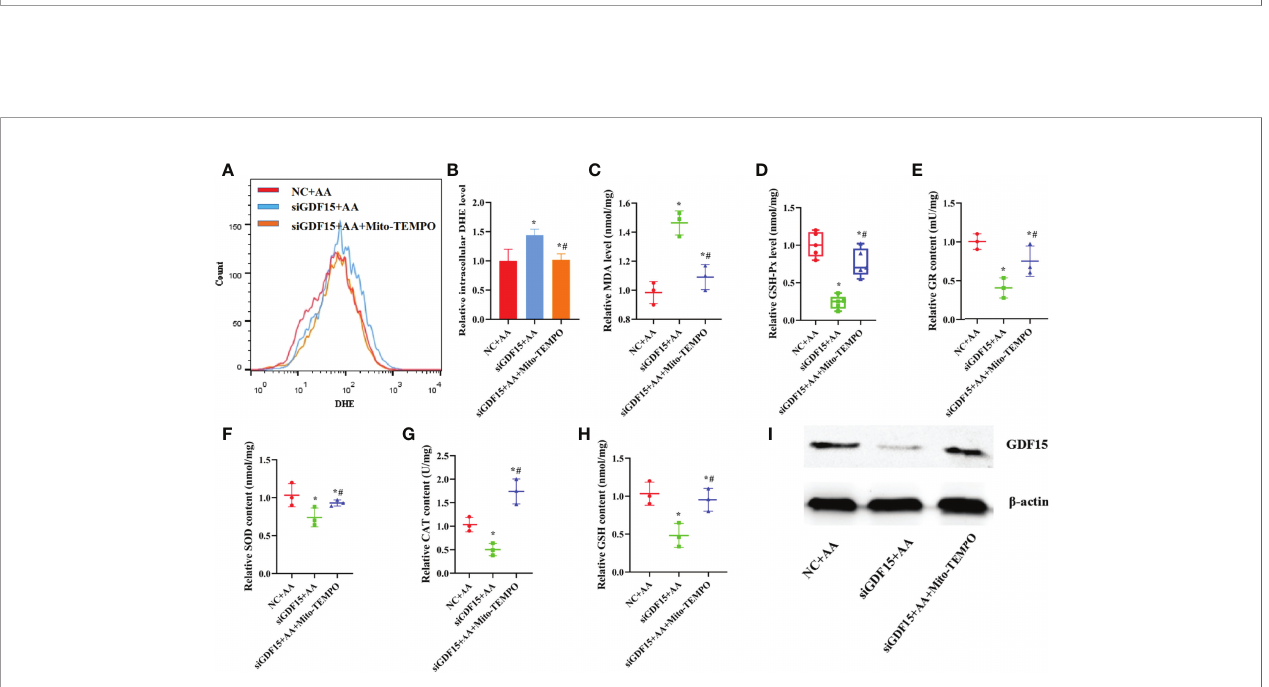
FIGURE 6 | Silencing of GDF15 caused damage to antioxidant capability of KGN cells (A, B) silencing of GDF15 signi fi cantly promoted the levels of O 2- levels in KGN cells (C – H) Silencing of GDF15 promoted the levels of MDA and weakened the activities of antioxidant enzymes SOD, CAT, GSH-Px and GR in KGN cells and the GSH content (I) Silencing of GDF15 signi fi cantly decreased the level of GDF15 protein. Data represent mean ± standard error, *P < 0.05, * # P <